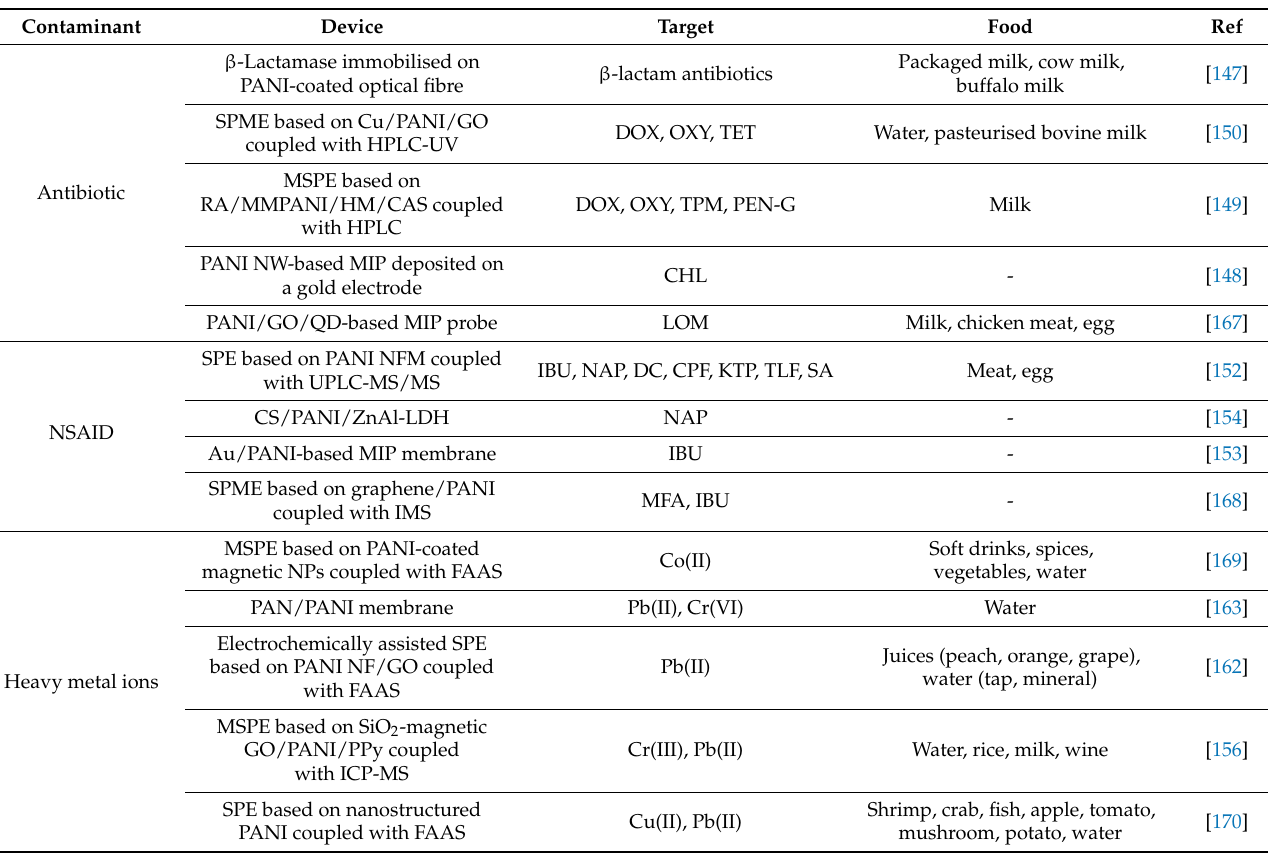
Table 4. Detection and/or extraction of contaminants such as antibiotics, NSAIDs, and heavy metal ions by PANI-based